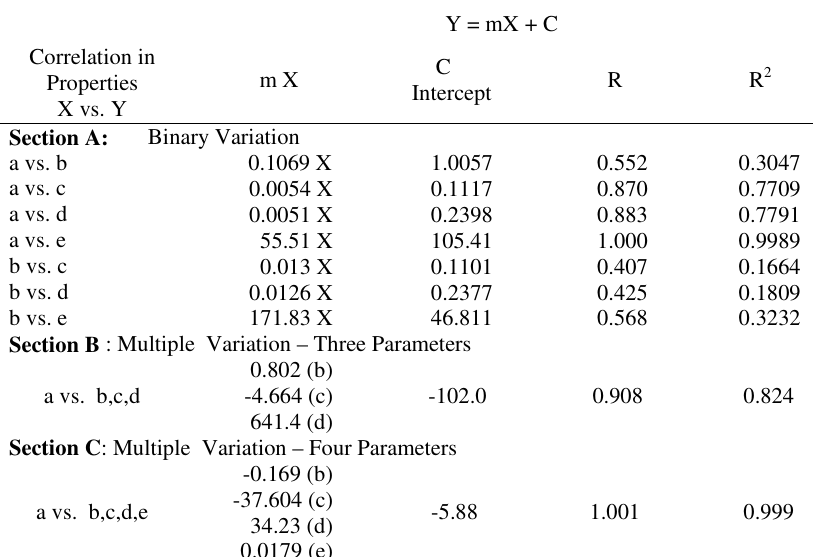
Table – 2 Variation in the Lipophilicity Distributive parameters and The Dipole Moment values with Dependable parameters with their Slope Values, Intercepts, R and R 2 Values for Binary and